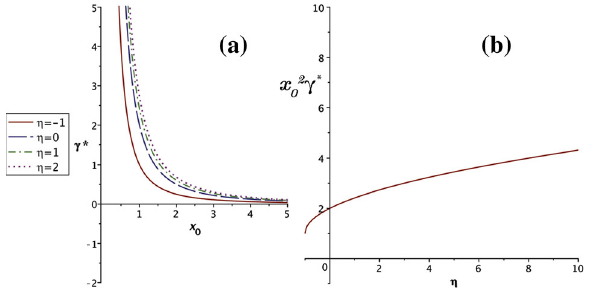
Fig. 4 For a CS–CS ∗ ATSW incase a variable EoS where β 2 (cid:4)= − 1 / 2, a shows γ ∗ plotted against x 0 for four different values of η ( η = − 1 is an inaccessible limit), and b shows γ ∗ x 2 implies the stable region